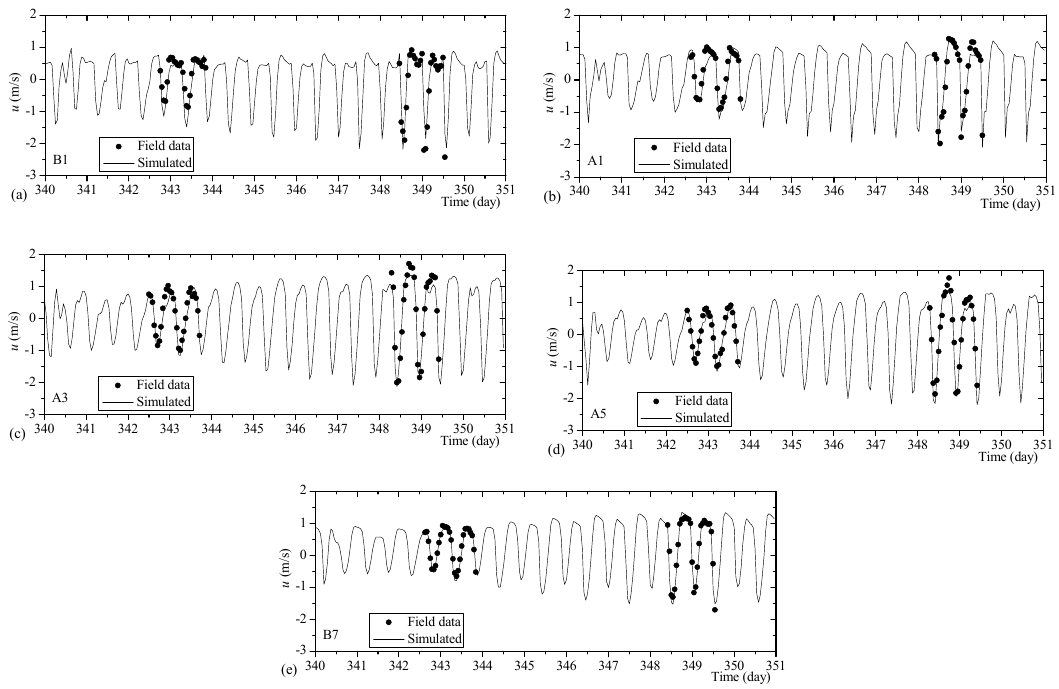
Figure 5. Comparisons of simulated histories of velocity with field data (negative velocity is landward velocity, which appears during the flood duration). ( a ) at Survey Point B1, ( b ) at Survey Point A1, ( c ) at Survey Point A3, ( d ) at Survey Point A5, ( e ) at Survey Point B7.